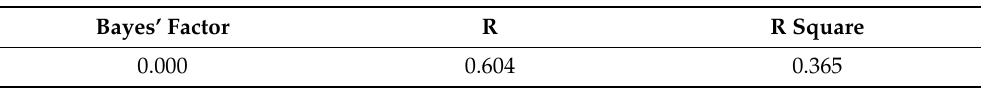
Table 11. Summary of the explanatory power of the variability captured by the proposed model for the probability of successful escape. Bayes’ Factor R R